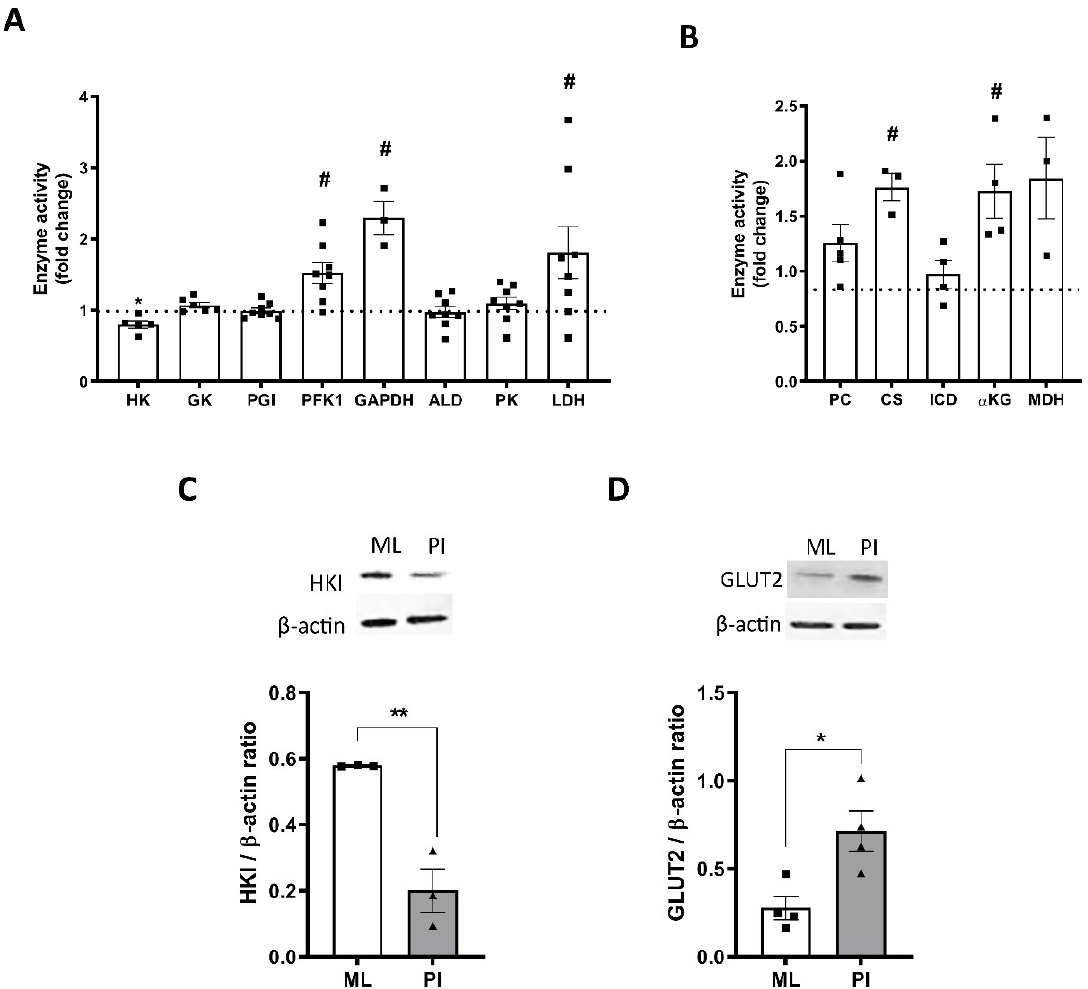
Figure 5. Pseudoislet formation alters expression and activity of glycolytic and TCA cycle enzymes. MIN6 cells (passage 26–29) were cultured in either standard cell culture plates (ML) or in un-coated Petri-dishes (PI) for 5 days. ( A , B ) Changes in enzyme activity for glycolytic enzymes ( A ) or TCA cycle enzymes ( B ) was determined on cell lysates from ML and PI and activity corrected for protein content. ( C , D ). Changes in protein expression of HK ( C ) and GLUT2 ( D ) were determined using Western blotting and expressed relative to β -actin. Results are expressed as fold change relative to ML ( A , B ) or as GLUT2 or HK: β -actin ratio ( C , D ). n = 3–8. * p < 0.05, ** p < 0.01, # p < 0.05 using an unpaired t ‐ test.